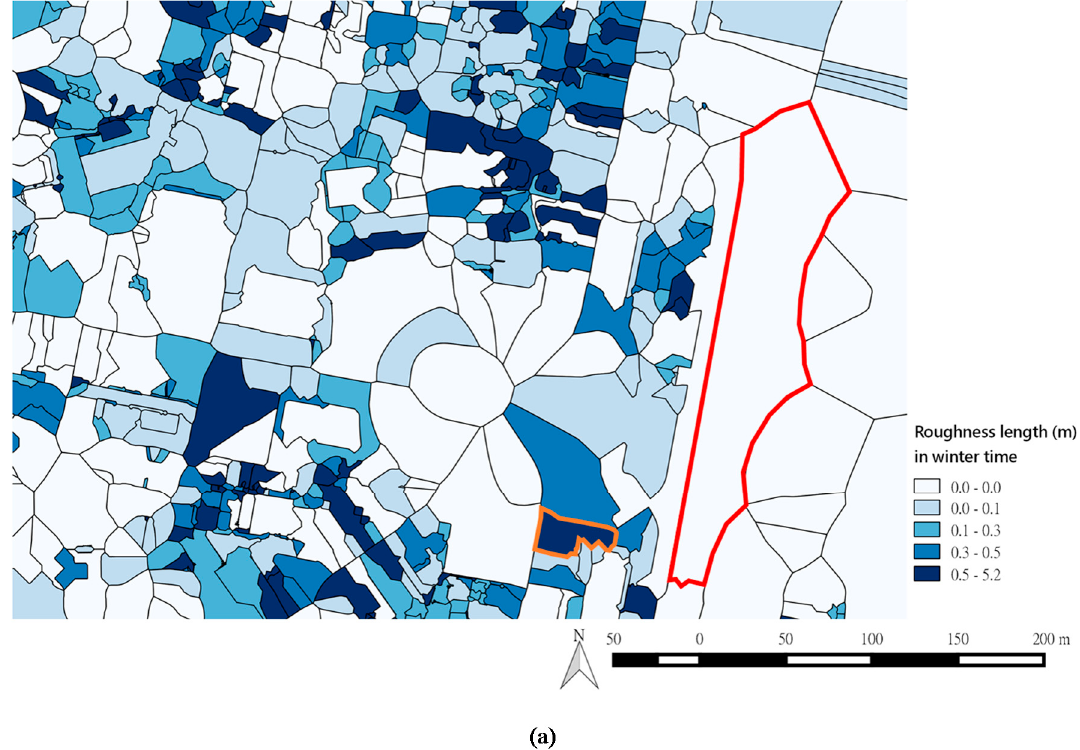
Figure 9. Cont. Figure 8.